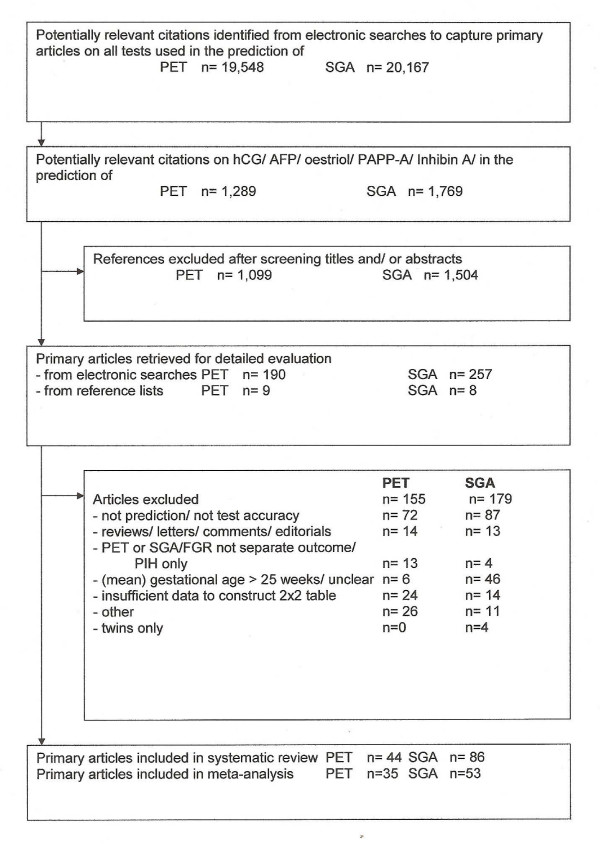
Process from initial search to final inclusion for biochemical screening to predict pre-eclampsia/small for gestational age (up to February 2007). PET preeclampsia; PIH pregnancy induced hypertension; SGA small for gestational age.